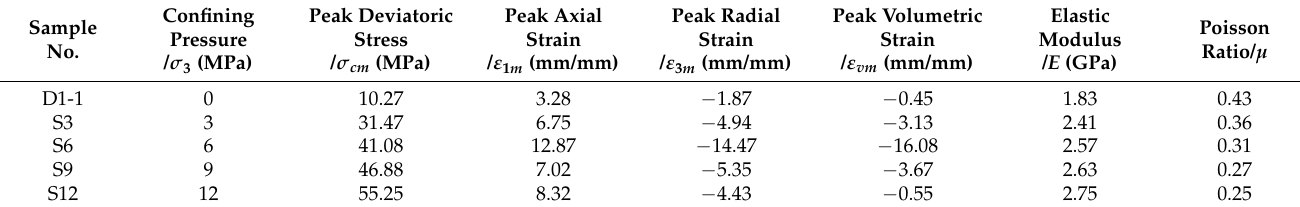
Figure 6. Fitting results of peak strength under different strength criteria. Table 2 lists the results of coal under triaxial compression tests, and the deviatoric stress–strain curves are shown in Figure 5. Table 2. Mechanical test results of samples with 0°. Table 2. Mechanical test results of samples with 0 ◦ .